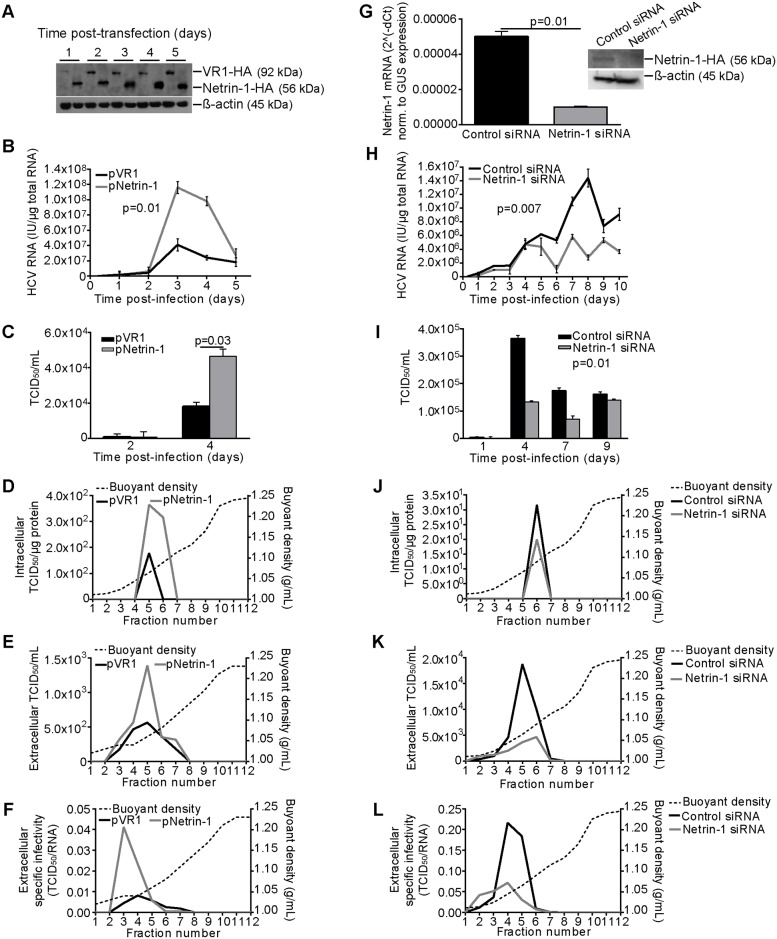
Netrin-1 overexpression increases HCV RNA and specific infectivity of HCV virions in vitro whereas Netrin-1 depletion decreases HCV RNA and specific infectivity in vitro.
A. Detection of VR1-HA and Netrin-1-HA in transfected Huh7.5 cells by immunoblotting with the anti-HA antibody. B. Netrin-1 overexpression enhances intracellular HCV RNA. Huh7.5 cells were transfected with the VR1-HA or the Netrin-1-HA plasmid and infected at a MOI of 0.1 the day after seeding. Intracellular HCV RNA was quantified by RT-qPCR at each time point (data are shown as mean ± standard deviation, n = 3, Wilcoxon test, p < 0.05). C. Supernatant infectivity was quantified on days two and four post-infection by the TCID50 method (n = 3, Mann-Whitney test, p < 0.05.). D. Intracellular infectivity was quantified on day four post-infection by the TCID50 method (n = 3). E. Density of infectivity values was quantified for each collected sucrose gradient fraction, 3 d post-infection, by the TCID50 method (n = 3). Buoyant densities were determined by refractometry. F. Netrin-1 increases the specific infectivity of virions. Specific infectivity was calculated for each collected fraction using the TCID50/HCV RNA ratio and refractometry (n = 3). G. Assessment of Netrin-1 mRNA knockdown. Cells were initially transfected with control and Netrin-1-specific siRNAs, then harvested at the indicated time points and processed for Netrin-1 mRNA quantification by RT-qPCR or by immunoblotting in microsomes using an anti-Netrin-1 antibody (data are shown as mean ± standard deviation, n = 3, Mann-Whitney test, p < 0.05). H. Netrin-1 depletion impedes HCV. Huh7.5 cells were transfected with siRNAs, infected at a MOI of 0.1 24 h after seeding, and trypsinized at day five post-infection before a second siRNA transfection. Intracellular HCV RNA was quantified by RT-qPCR at each time point (data shown as mean ± standard deviation, n = 3, Wilcoxon test, p < 0.05). I. Supernatant infectivity was quantified on days one, four, seven, and nine post-infection by the TCID50 method (n = 3, Wilcoxon test, p < 0.05). J. Intracellular infectivity was quantified on day four post-infection by the TCID50 method (n = 3). K. 6 d post-infection, culture supernatants were subjected to sucrose gradient centrifugation, and infectivity was quantified in each collected fraction by the TCID50 method. Buoyant densities were determined by refractometry (n = 3). L. Netrin-1 depletion decreases specific infectivity of virions. Specific infectivity was calculated for each collected fraction using the TCID50/HCV RNA ratio. (n = 3). The underlying data for panels in this figure can be found in S1 Data.